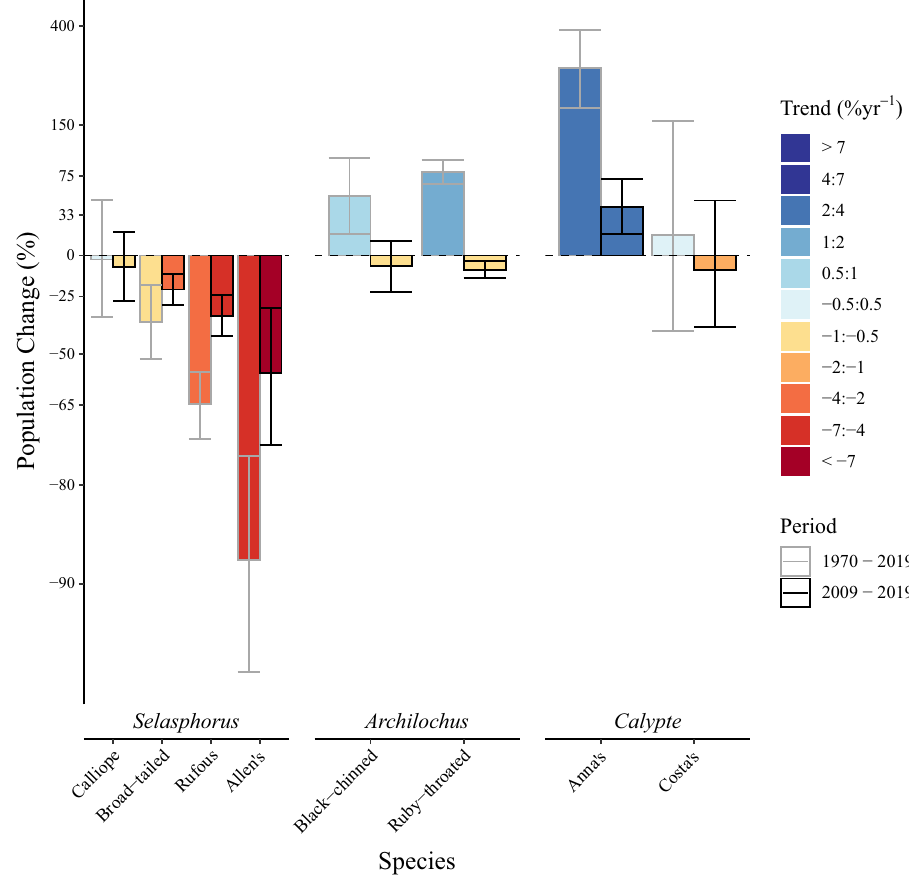
Figure 1. Percent change in populations of calliope hummingbirds ( Selasphorus calliope ), broad-tailed hummingbirds ( Selasphorus platycercus ), rufous hummingbirds ( Selasphorus rufus ), Allen’s hummingbirds ( Selasphorus sasin ), black-chinned hummingbirds ( Archilochus alexandri ), ruby-throated hummingbirds ( Archilochus colubris ), Anna’s hummingbirds ( Calypte anna ), and Costa’s hummingbirds ( Calypte costae ) across North America. Vertical axes scale to symmetry on the log-scale to accurately represent the percent change necessary for a population to recover to initial size at the beginning of the period. Column colours scaled to rate of change where darker hues reflect a greater rate of change. Errors shown are the upper and lower bounds of 90%